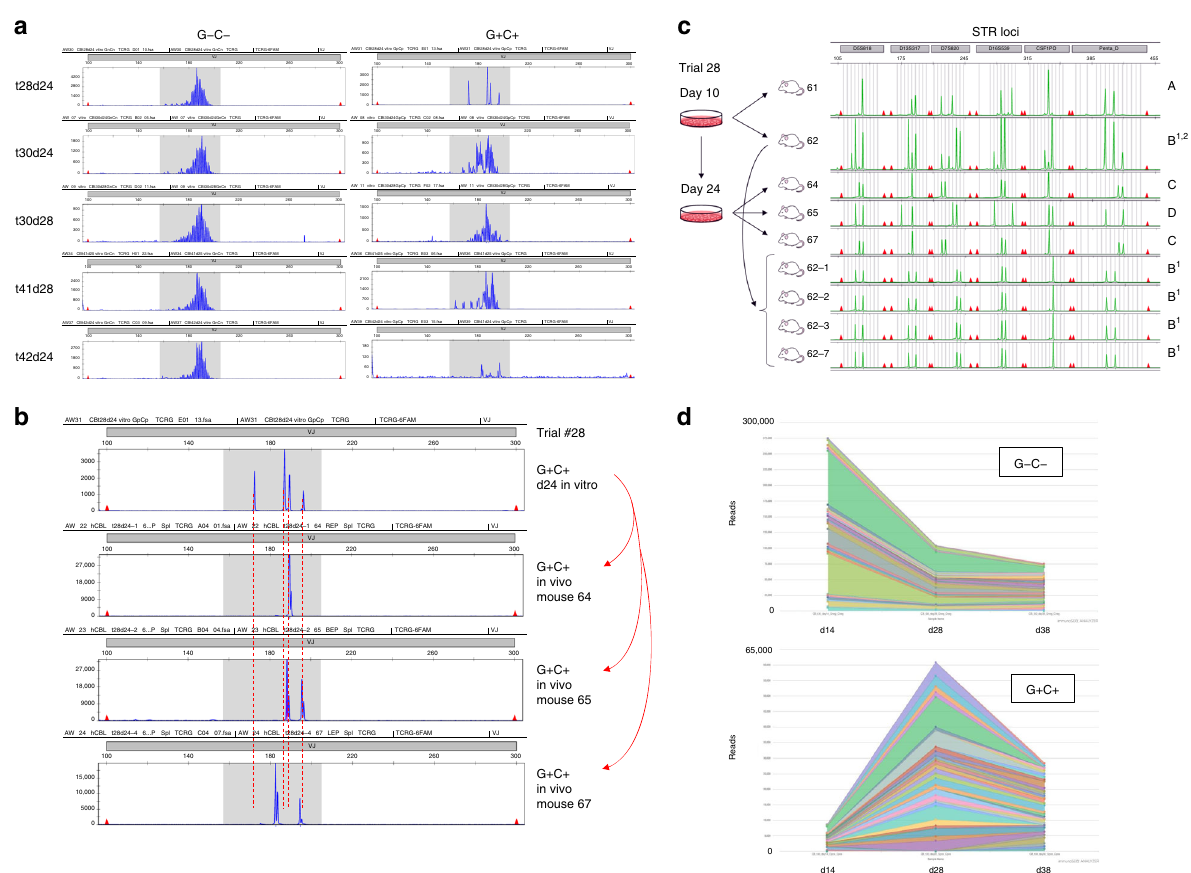
Fig. 3 NLTB-transduced CB cells do not develop into clonally rearranged leukemias in vitro. a , b BIOMED-2 TCRG clonality assay. a CB cells were transduced with N + LTB lentiviruses and cultured on OP9-DL1 feeders for up to 28 days. Doubly transduced (G + C + ) and nontransduced (G − C − ) subsets of cells were FACS sorted and genomic DNA extracted for analysis. No dominant peaks indicative of clonal T-cell populations were identi fi ed in any of these samples. b Doubly transduced (G + C + ) CB cells were FACS sorted from day 24 in vitro cultures, as well as from the leukemic mice into which the cultured cells were injected. Genomic DNA was then extracted, and the distribution of ampli fi ed TCRG DNA fragments analyzed by GeneScan (Applied Biosystems). Dotted red lines are overlaid to facilitate comparison of peak sizes between samples. Peak sizes are reproducible within less than 0.5 bp. c STR pro fi ling of CB leukemias. Genomic DNAs from primary CB leukemias were pro fi led by Promega PowerPlex 16HS assay. STR patterns from four different individual donors (A, B1, C, D) can be discerned. The minor B2 pattern was not represented after serial transplant. d ImmunoSEQ TCRG clonality assay. CB cells were transduced with N + LTB lentiviruses and cultured on OP9-DL1 feeders. Culture samples were taken at 14, 28, and 38 days. Doubly transduced (G + C + ) and nontransduced (G − C − ) subsets were FACS sorted and genomic DNA extracted for ImmunoSEQ TCRG (Survey) analysis by Adaptive Biotechnologies. Stacked reads are plotted for the 25 most frequent rearrangements with each alternating color indicating a unique, clonally rearranged CDR3 DNA